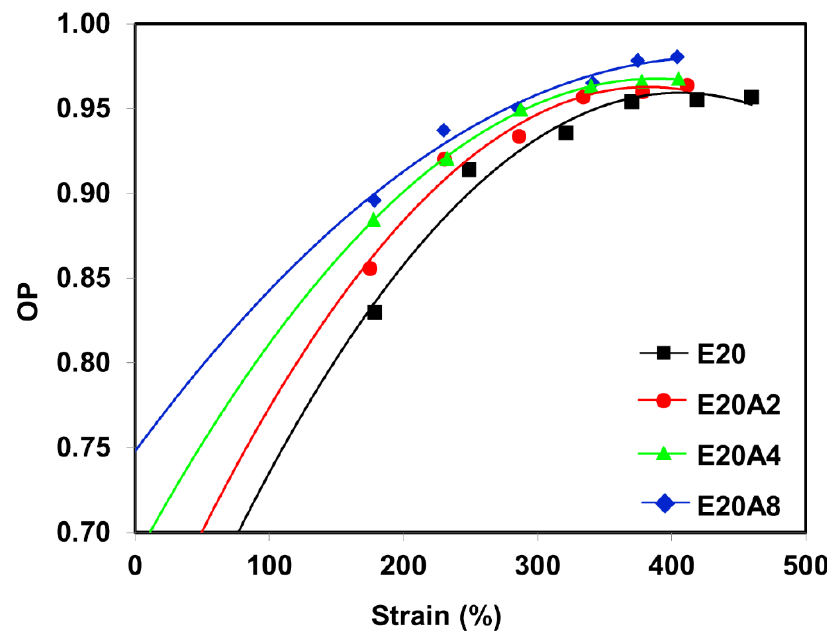
Figure 13. Strain dependence of the orientation parameter for ENR/HNT composites filled with untreated and acid-treated HNT.